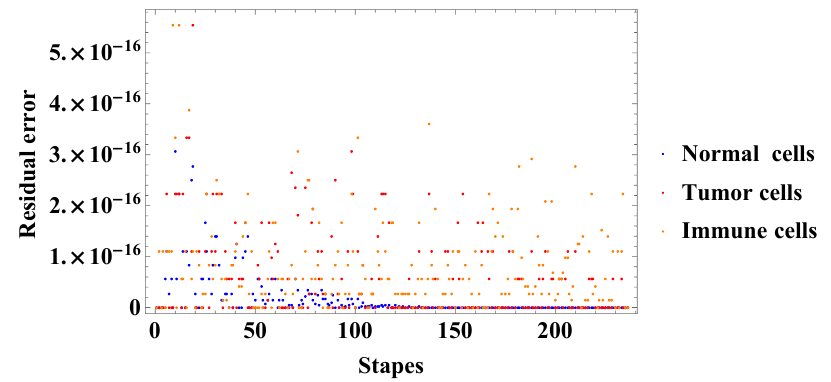
Figure 4. The residual error at various steps for NTIUNHDM.